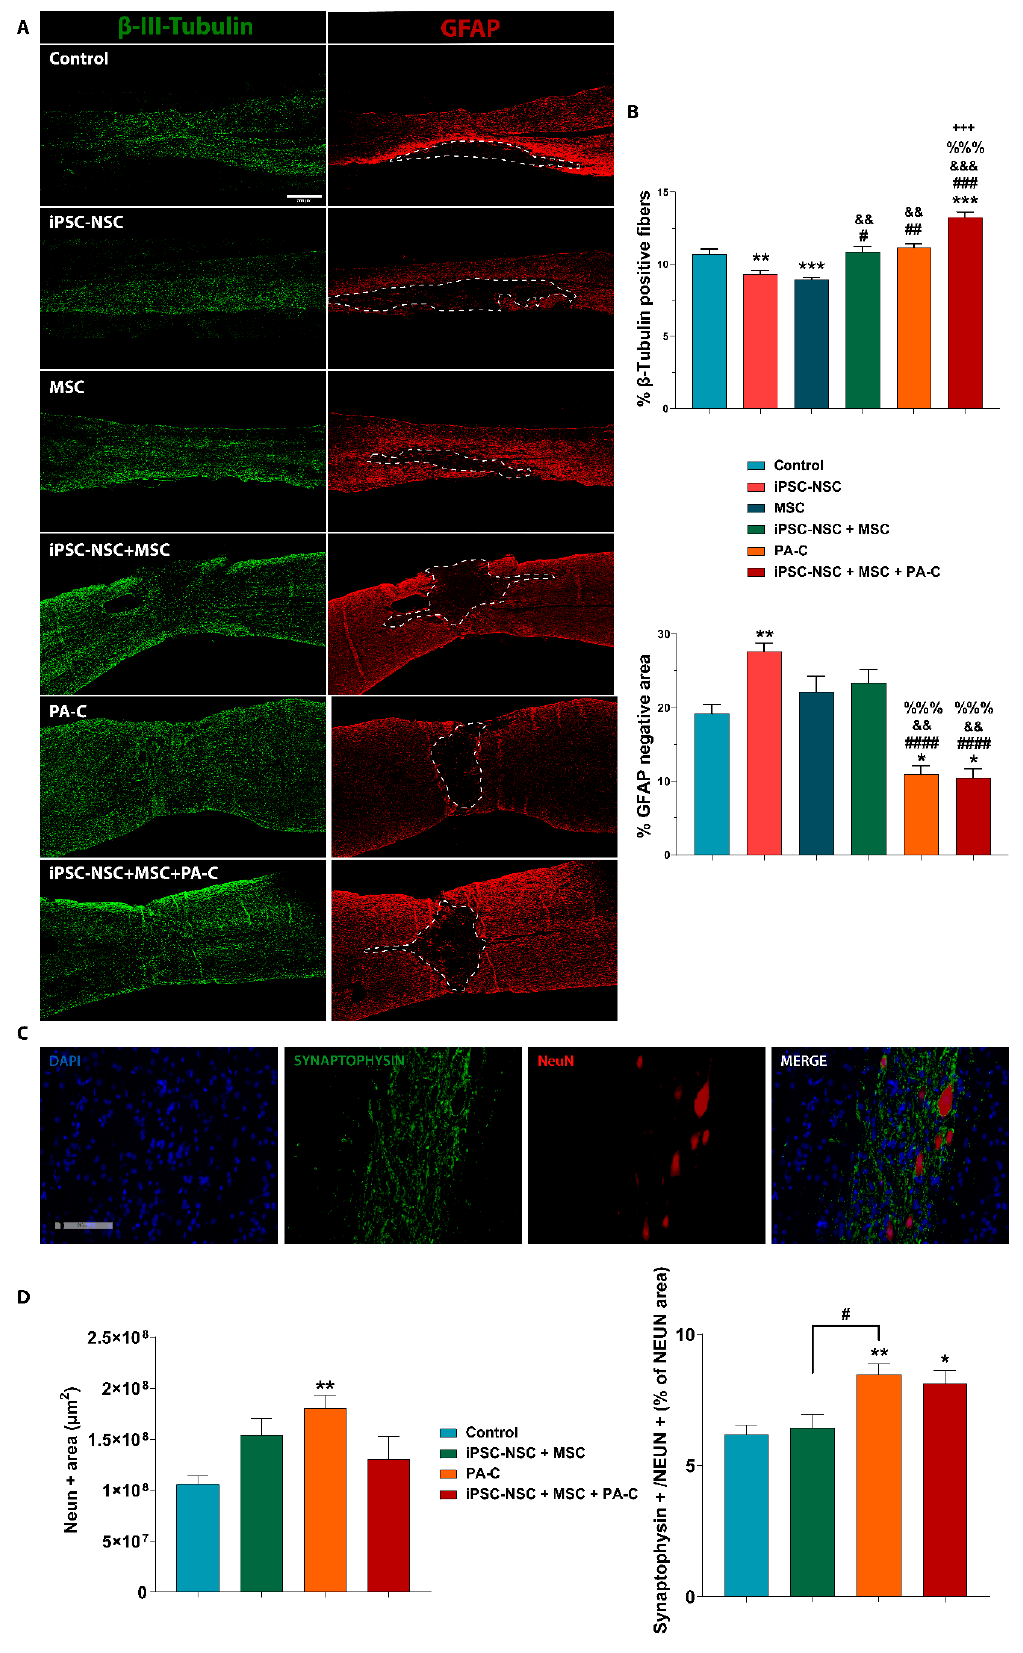
Figure 6. ( A ). PA-C and PA-C combined with iPSC-NSC + MSC transplantation preserves β -III-Tubulin fibers and synapses and reduces scar size A. Representative immunofluorescence images ( left panel ) of β -III-Tubulin (green) and GFAP